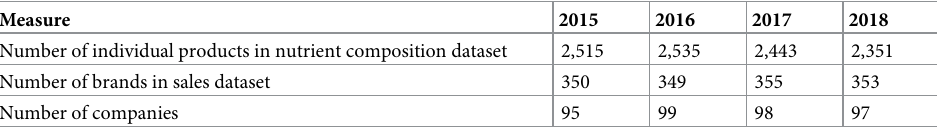
Table 2. Data points in the nutrient composition and sales datasets